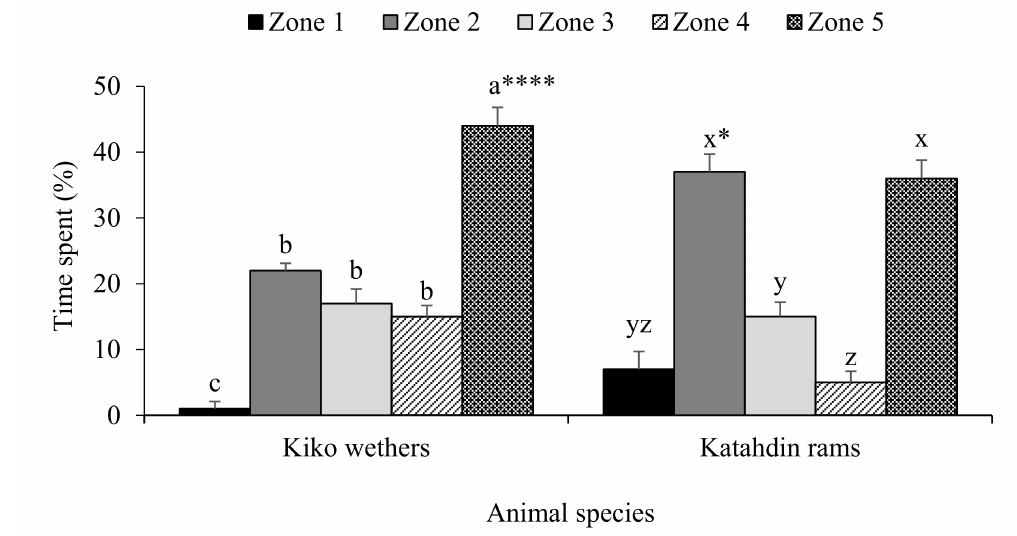
Figure 5. Diurnal (dawn–dusk) time (LS means ± SE) spent by Kiko wethers and Katahdin rams in different zones in woodlands, June–August 2018 ( a,b,c x,y,z LS means with different superscripts within each animal species differ; * p < 0.05, **** p < 0.0001). Zones 1 to 5 are defined in Figure 1.